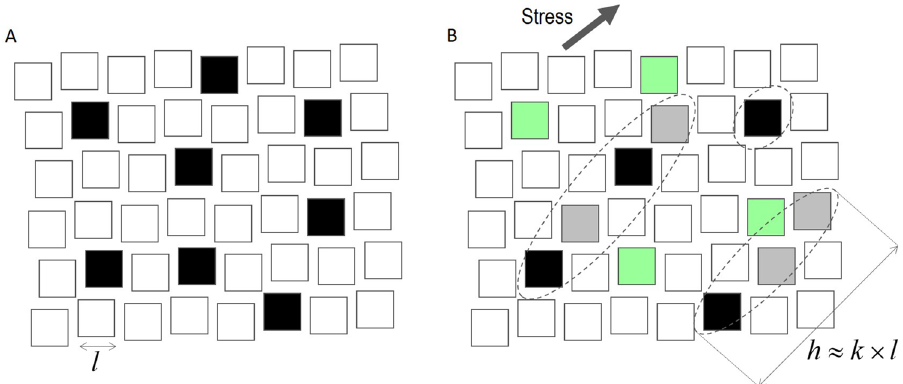
Figure 1. 2D scheme of the glass description in a PEL approach. ( A ) The glass is divided in “clusters” with same size, formed in average of the same number but different atoms. Clusters are distributed over the PEL, where some (black) are in favorable energy configuration with respect to an external solicitation. ( B ) Orientation of the external stress solicitation produces selection of clusters (black) favorably oriented. Though energetically favorable, green clusters are not favorably oriented with respect to the applied stress. In the complex PEL gradient, clusters (grey) nearby selected black clusters, energetically and favorably oriented can be triggered participating in the rearrangement in the stress